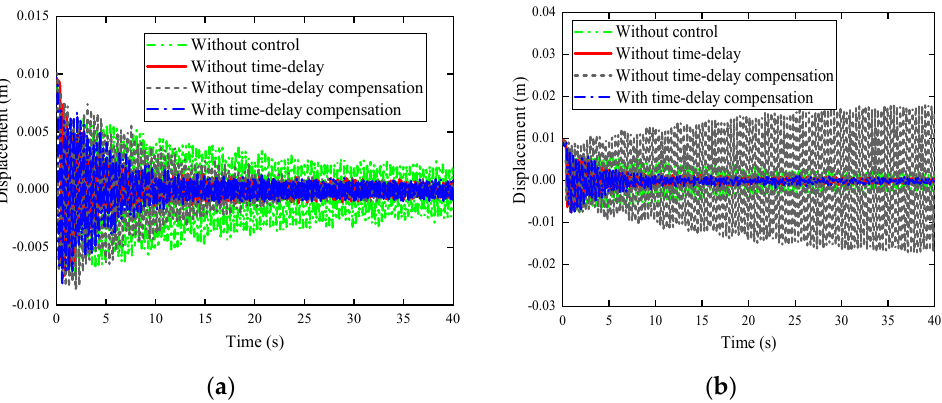
Figure 10. The time history of displacement at L/2 with time-delay under the free vibration experiments. ( a ) 0.11 s time-delay. ( b ) 0.13 s time-delay. Table 5. Experimental response reductions at mid-span under free vibration.